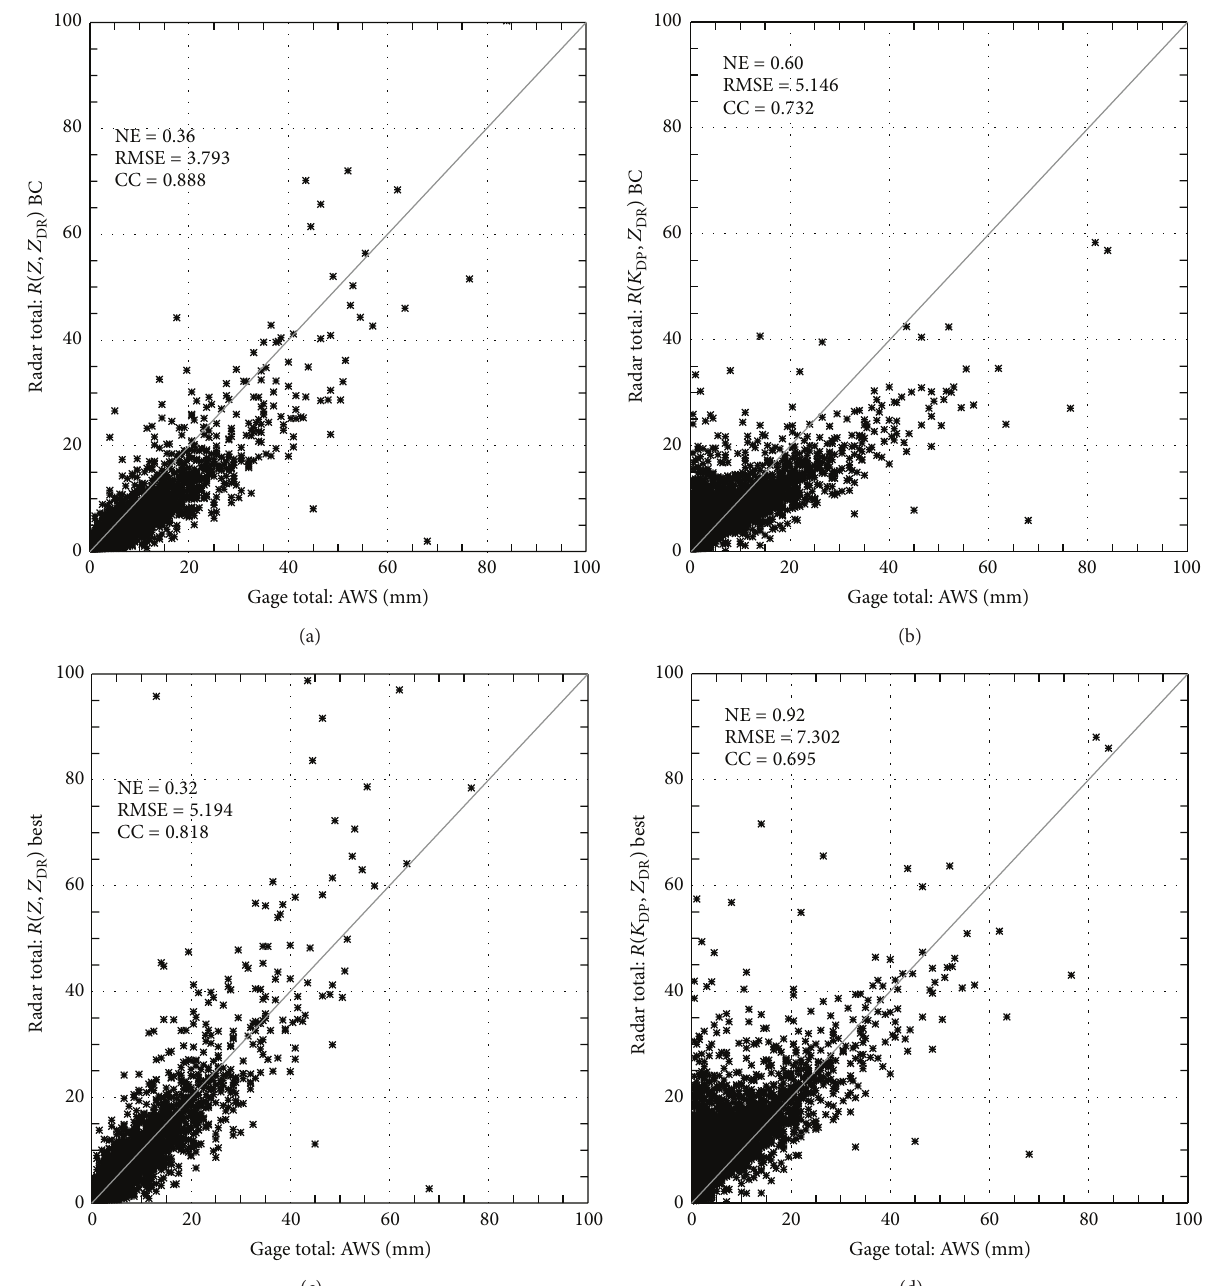
Figure 7: The scatter plot of rainfall from gage and (a) 𝑅(𝑍,𝑍 DR ) , (b) 𝑅(𝐾 DP , 𝑍 DR ) with single raindrop axis ratio relation, (c) 𝑅(𝑍,𝑍 DR ) , and (d) 𝑅(𝐾 DP ,𝑍 DR ) with two-raindrop axis ratio